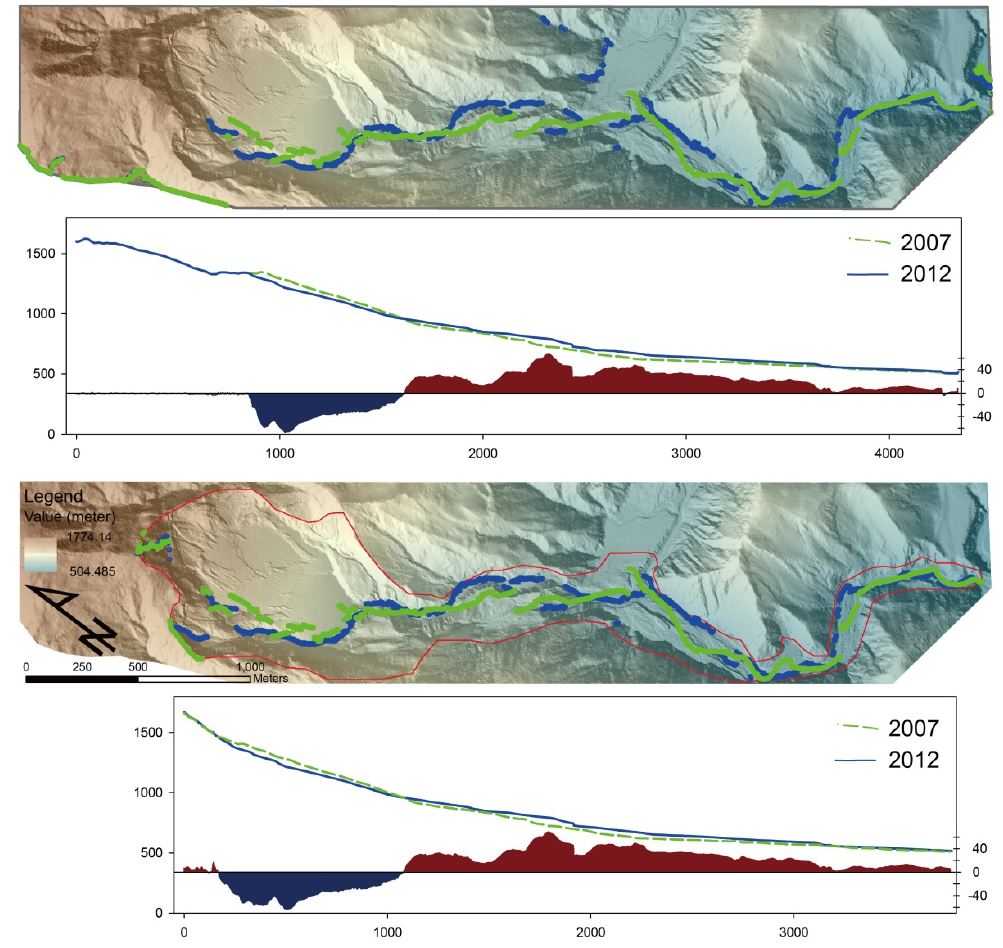
Figure 8. Swath profile calculation based on the terrain data obtained from 2007 ( before landslide ) and 2012 ( after landslide ). The first and the third subfigures show the swath profiles calculated using different target areas, i.e. , the entire rectangular range and the zone of depletion and the river channel, respectively. The results are, respectively, shown in the second and the fourth subfigures, where the green dashed line represents the elevation of 2007 while the blue line represents the elevation of 2012. The positions of sampling points are shown with the same colors in their corresponding maps. The bottoms of the profile subfigures illustrate the elevation changes during 2007–2012, where dark blue denotes elevation decrease, while dark red denotes elevation increase.